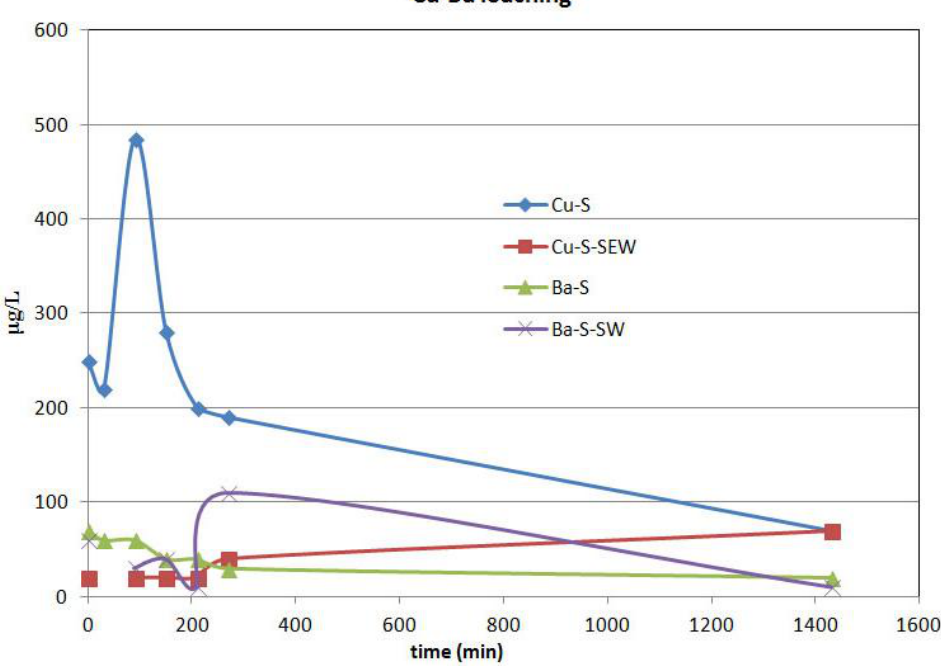
Figure 2. Evolution of Cu and Ba in the pilot-scale experiments. Values in μg/L. Cu/Ba-S: change of Cu and Ba content in time, measured in effluent solution of not-amended experiment; Cu/Ba-S-SW: change of Cu and Ba content in time, measured in effluent solution of amended experiment.